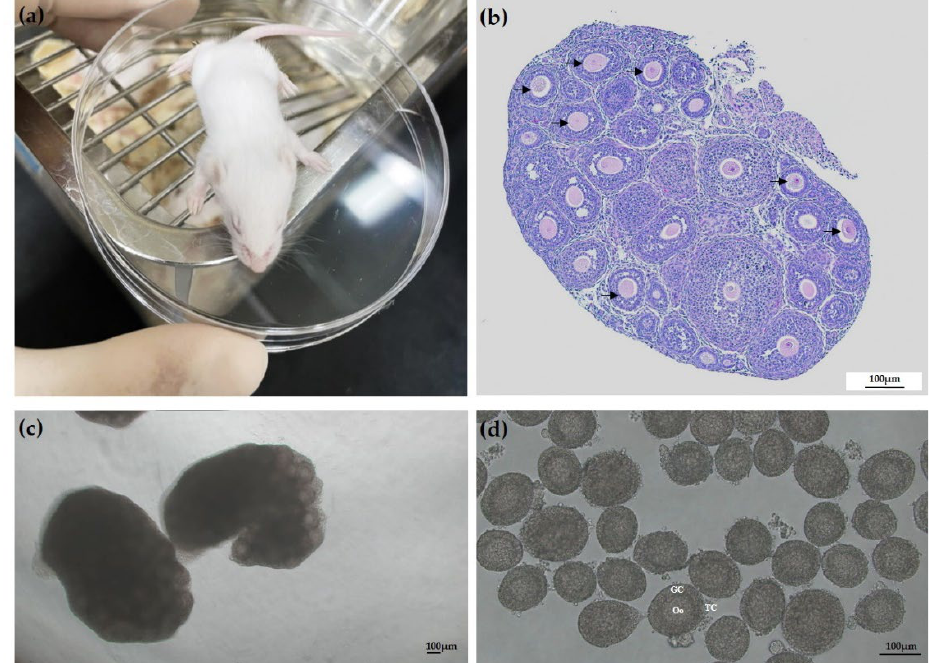
Figure 1. Representative images of manual isolation of single follicles from the ovaries of 14–16-day-old female mice. ( a ) Image of ICR mouse. ( b ) Hematoxylin and eosin staining of mouse ovary, which